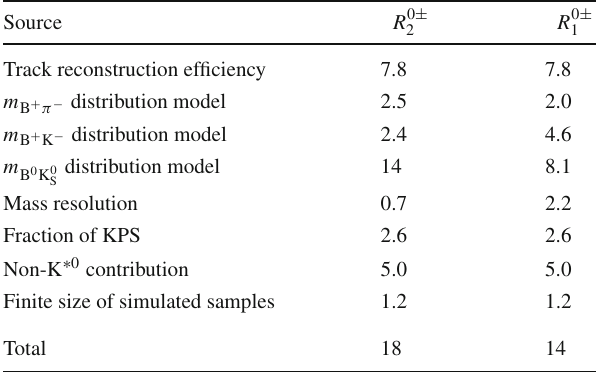
Table 3 Relative systematic uncertainties in percent in the ratios R 0 ±